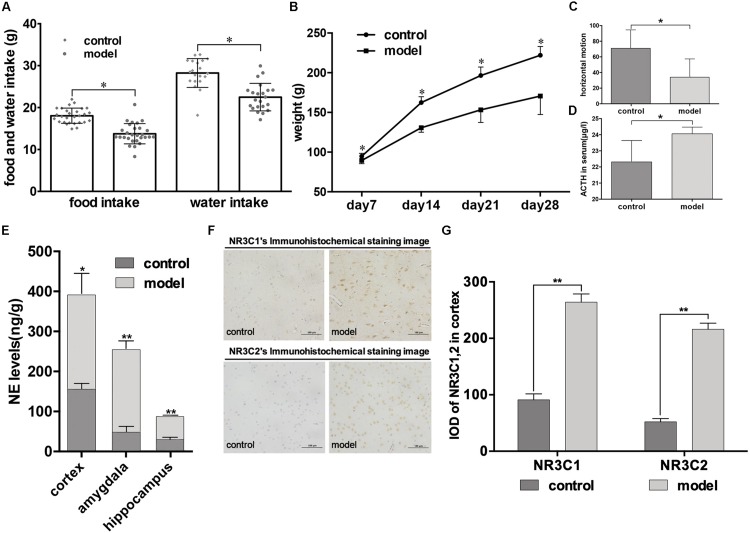
Impact of psychological stress stimulation on emotional phenotypes and indicators in rats. (A,B) Development of phenotypic changes after psychological stress. (A) Daily food and water intake in control and model groups (lozenges: control; circles: model; monitoring time: 28 days). (B) Weekly weight of rats in control and model groups (circles: control; squares: model; monitoring time: per week after stimulation, for 4 weeks). (C,D) Emotional phenotype and ACTH level changes after modeling (light gray: control; dark gray: model). (C) Results of the open field test were measured after stimulation for 28 days. Horizontal motion of rats in the open field was calculated (control, n = 12; model, n = 12). (D) ACTH levels in both groups were recorded (n = 6, each group). (E) NE levels in cortex, amygdala, and hippocampus measured by HPLC (n = 6, each group). (F,G) Immunohistochemical analysis of NR3C1 and NR3C2 expression in cortex on day 28 (n = 5, each group). Data shown as mean ± SD; ∗P < 0.05, ∗∗P < 0.01, model group vs. control group.